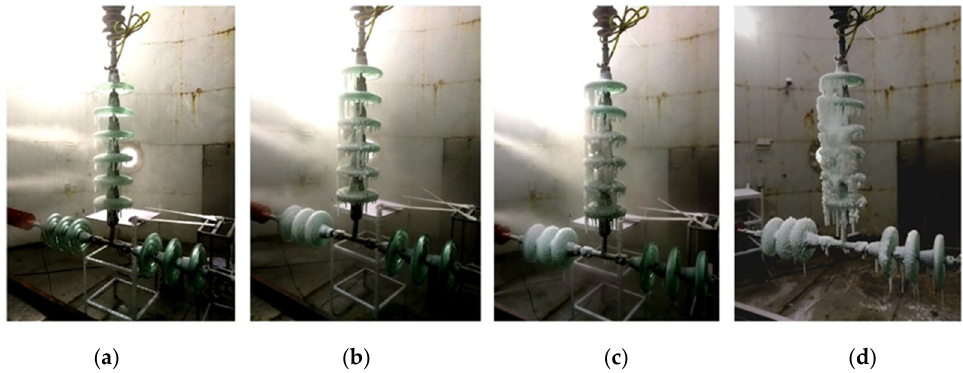
Figure 29. Inverted T-shaped arrangement icing situation of insulator string with different degrees. ( a ) D = 5 mm. ( b ) D = 10 mm. ( c ) D = 15 mm. ( d ) D = 20 mm [61].